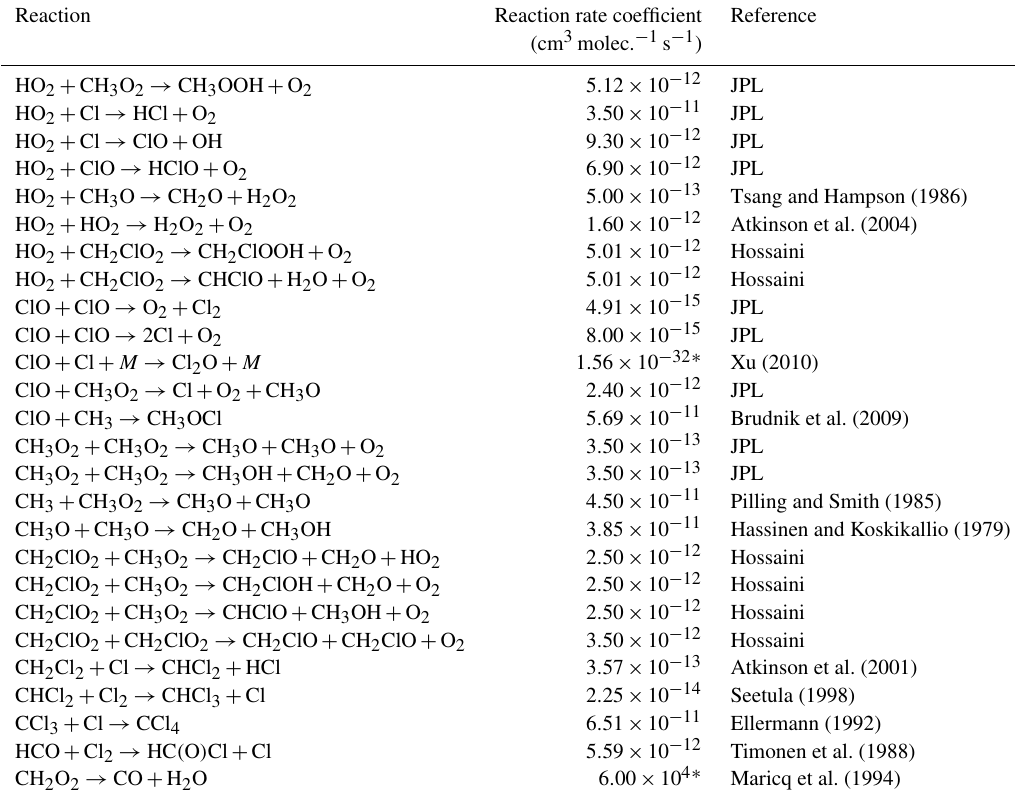
Table E3. JPL: Burkholder et al. (2020). Hossaini: Hossaini et al. (2016).